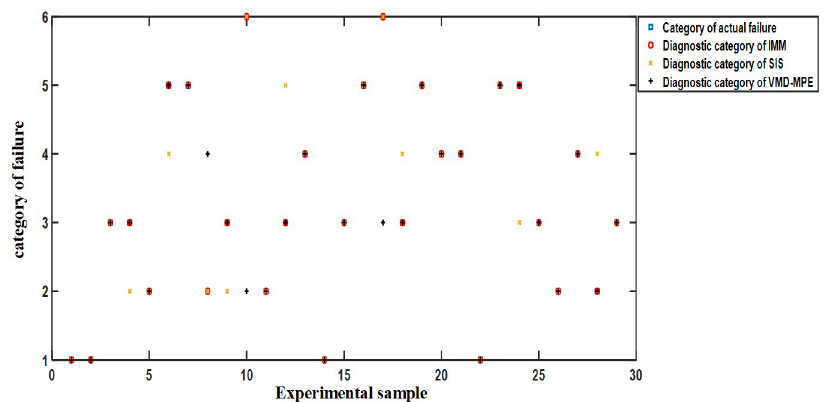
Fig 13. Fault diagnosis results of various methods in the case of noise.